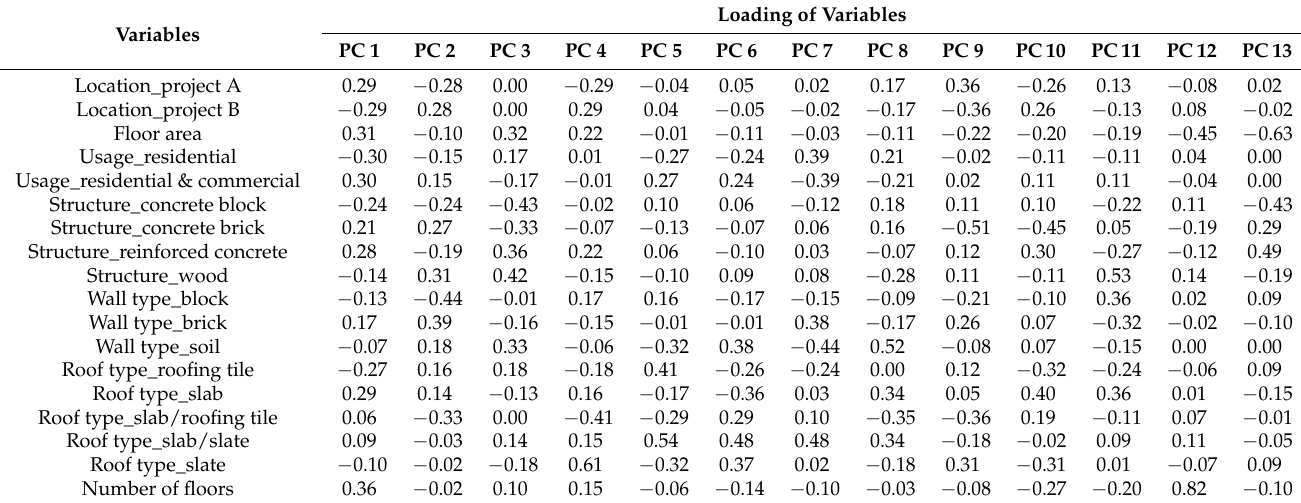
Table 3. Results of principal component analysis.